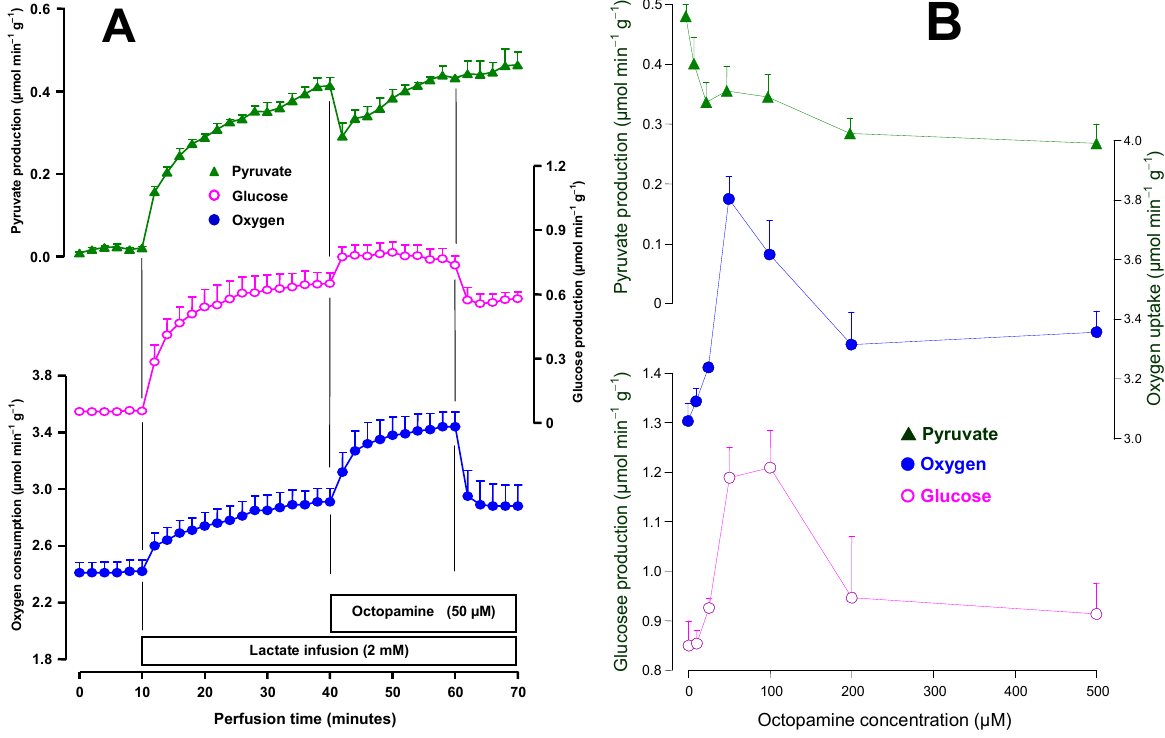
Figure 2. Effects of octopamine on lactate gluconeogenesis and associated parameters in the perfused liver of fasted rats. Livers were perfused as described in the experimental section. Lactate and octopamine were infused as indicated. Panel A illustrates the time courses of the changes caused by 500 μ M octopamine. And Panel B shows the concentration dependences of the changes caused by octopamine between 10 and 500 μ